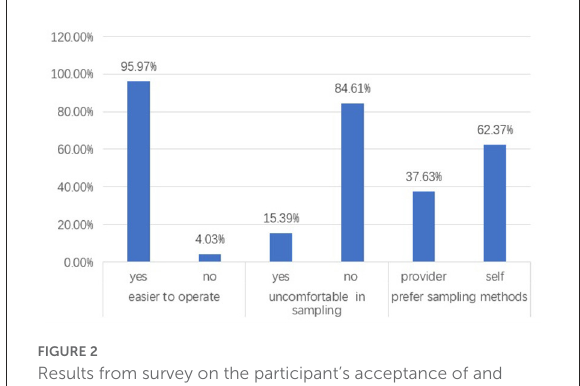
FIGURE2 Results from survey on the participant’s acceptance of and preference for self-sampling.